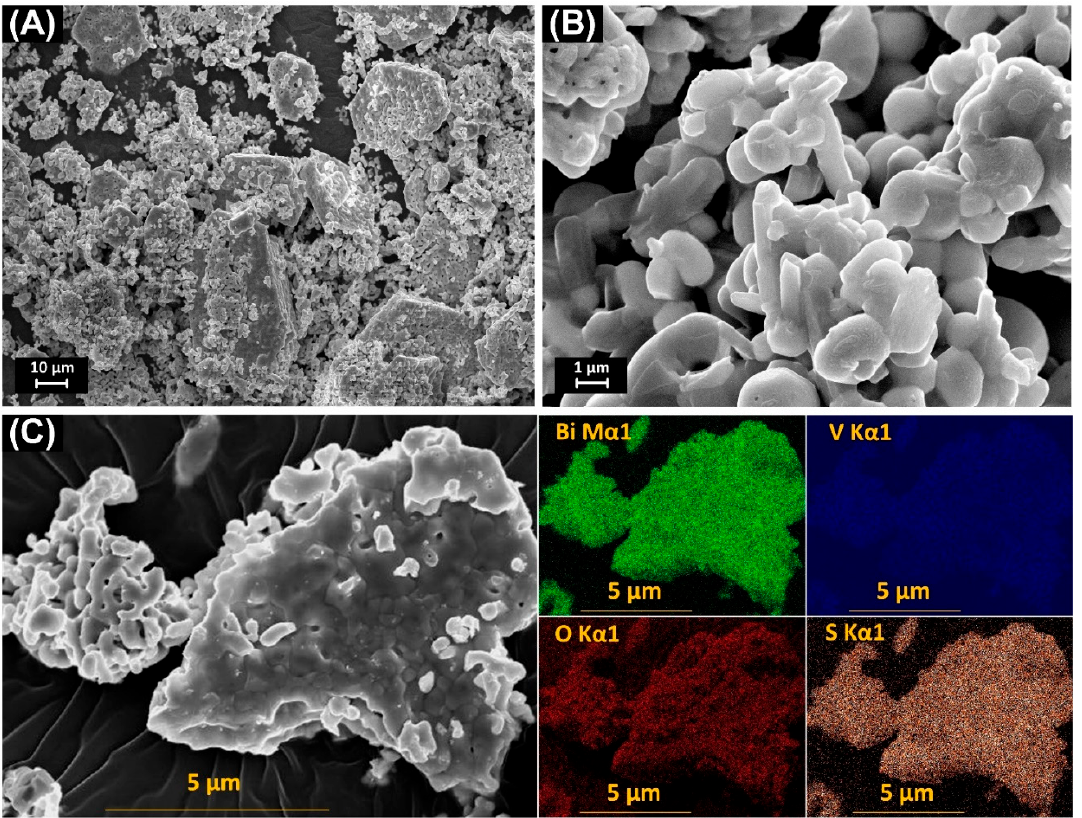
Table 2. Surface element compositions of the BVO-600 and T-BVO-600 samples.